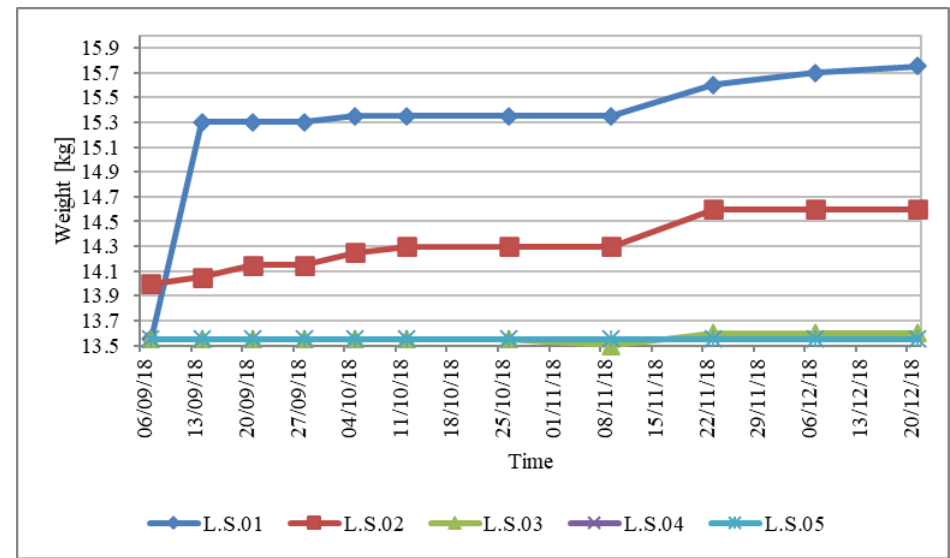
Figure 5. Weight-time absorption curves for the Lecce stone column (L.S.).